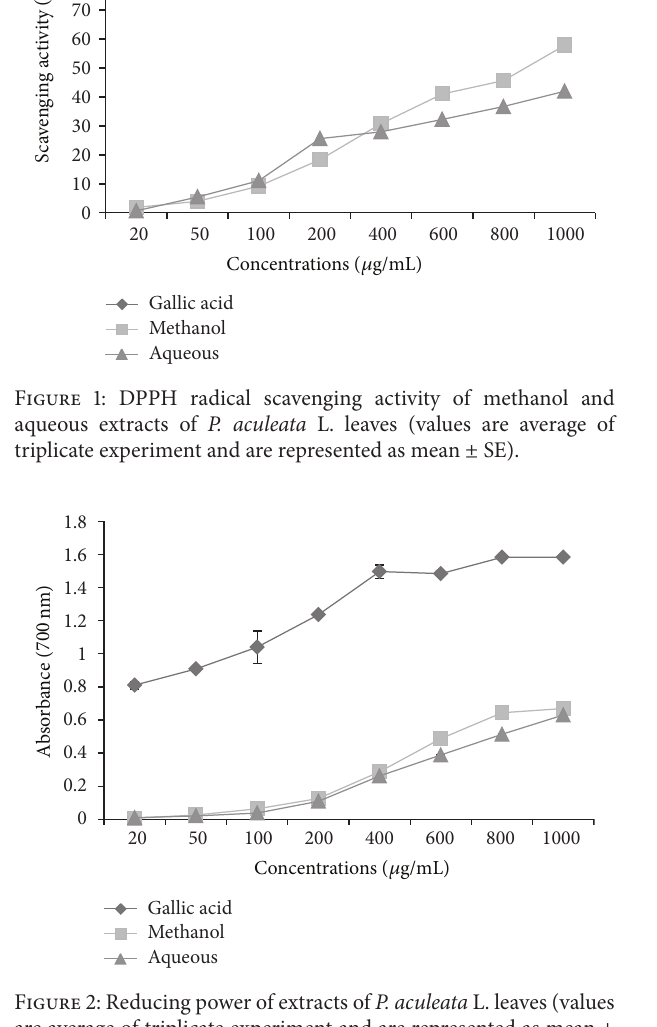
Figure 2: Reducing power of extracts of P. aculeata L. leaves (values are average of triplicate experiment and are represented as mean ± SE).